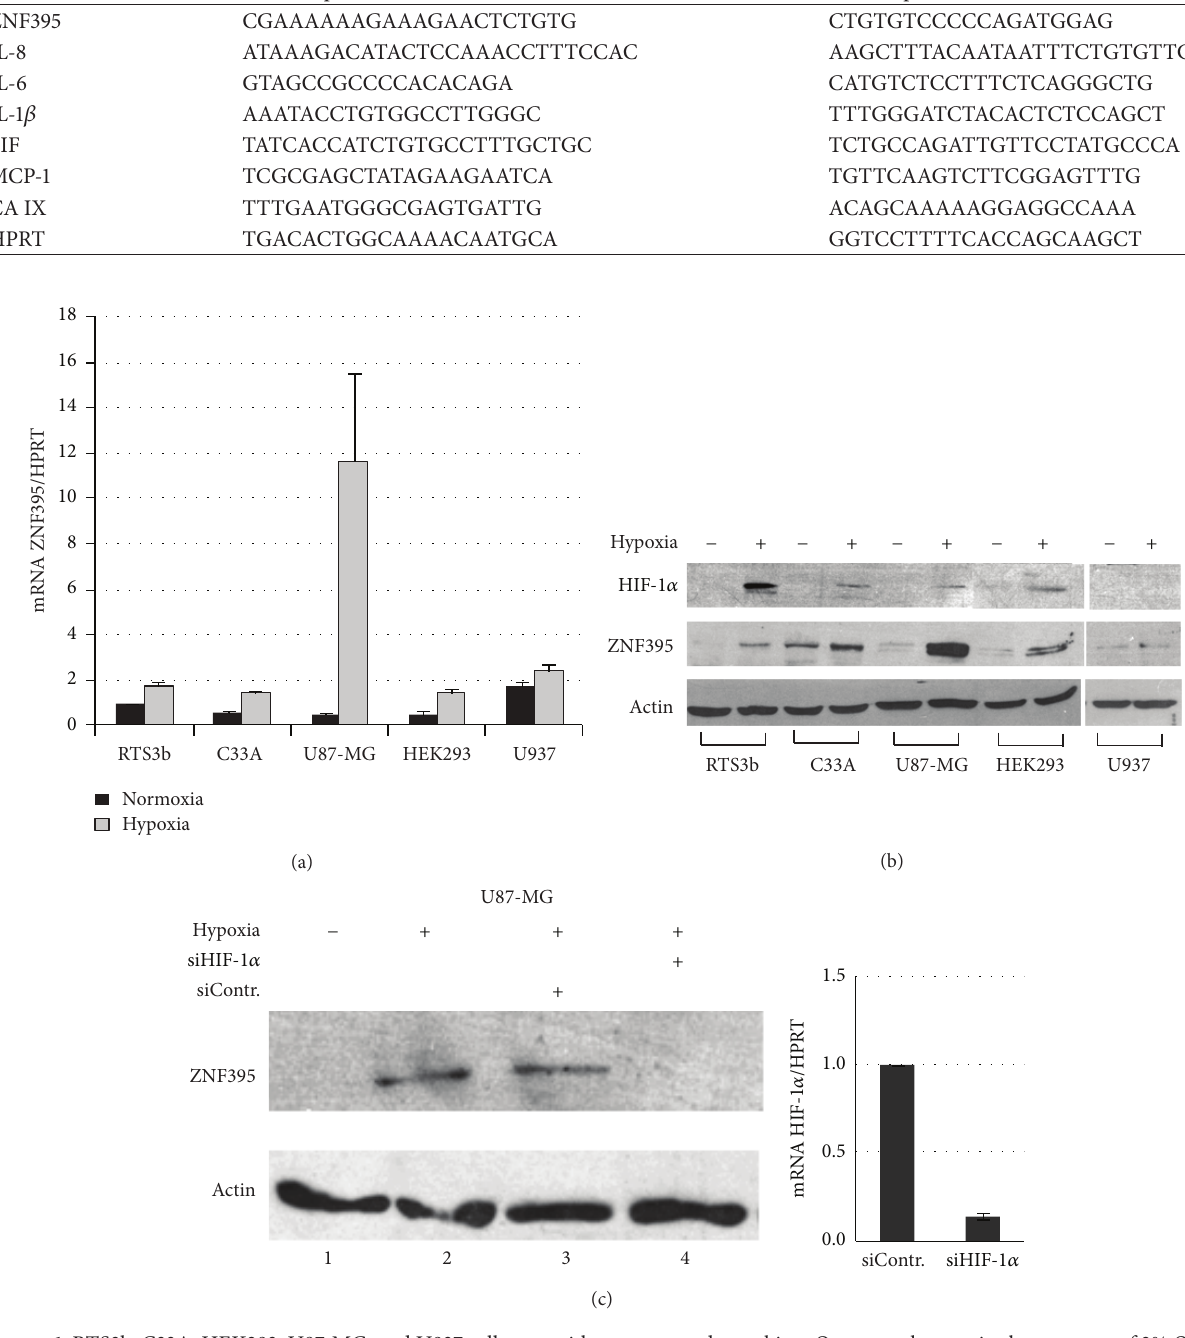
Figure 1: RTS3b, C33A, HEK293, U87-MG, and U937 cells were either grown under ambient O 2 atmosphere or in the presence of 2% O 2